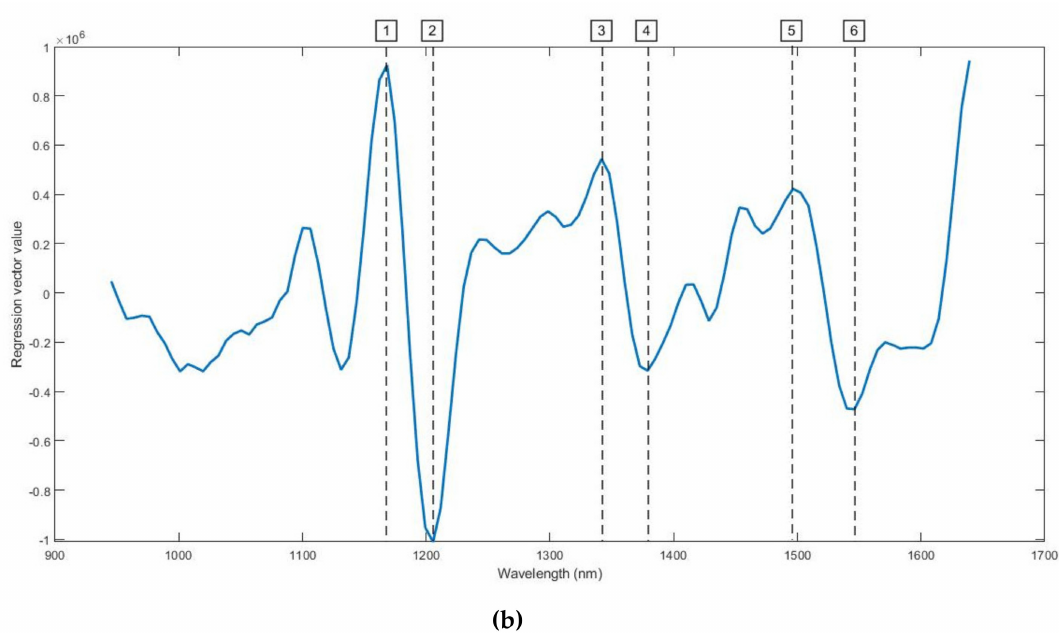
Figure 6. ( a ) Partial least squares regression plot for the prediction of GCV ad on WD gr . Spectra were pre-processed using second derivative (Savitzky-Golay filter, 13-points window, second-order polynomial) using six latent variables; ( b ) Corresponding regression vector plot using vertical lines and numbers to discriminate the most important